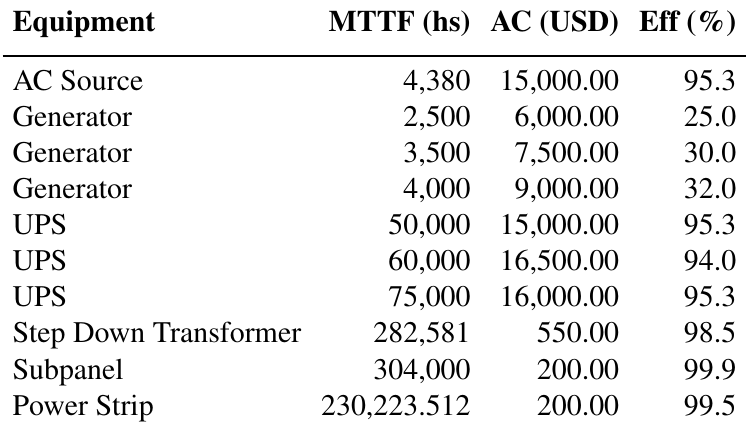
Table 4. MTTF, acquisition cost (AC) and efficiency (Eff)